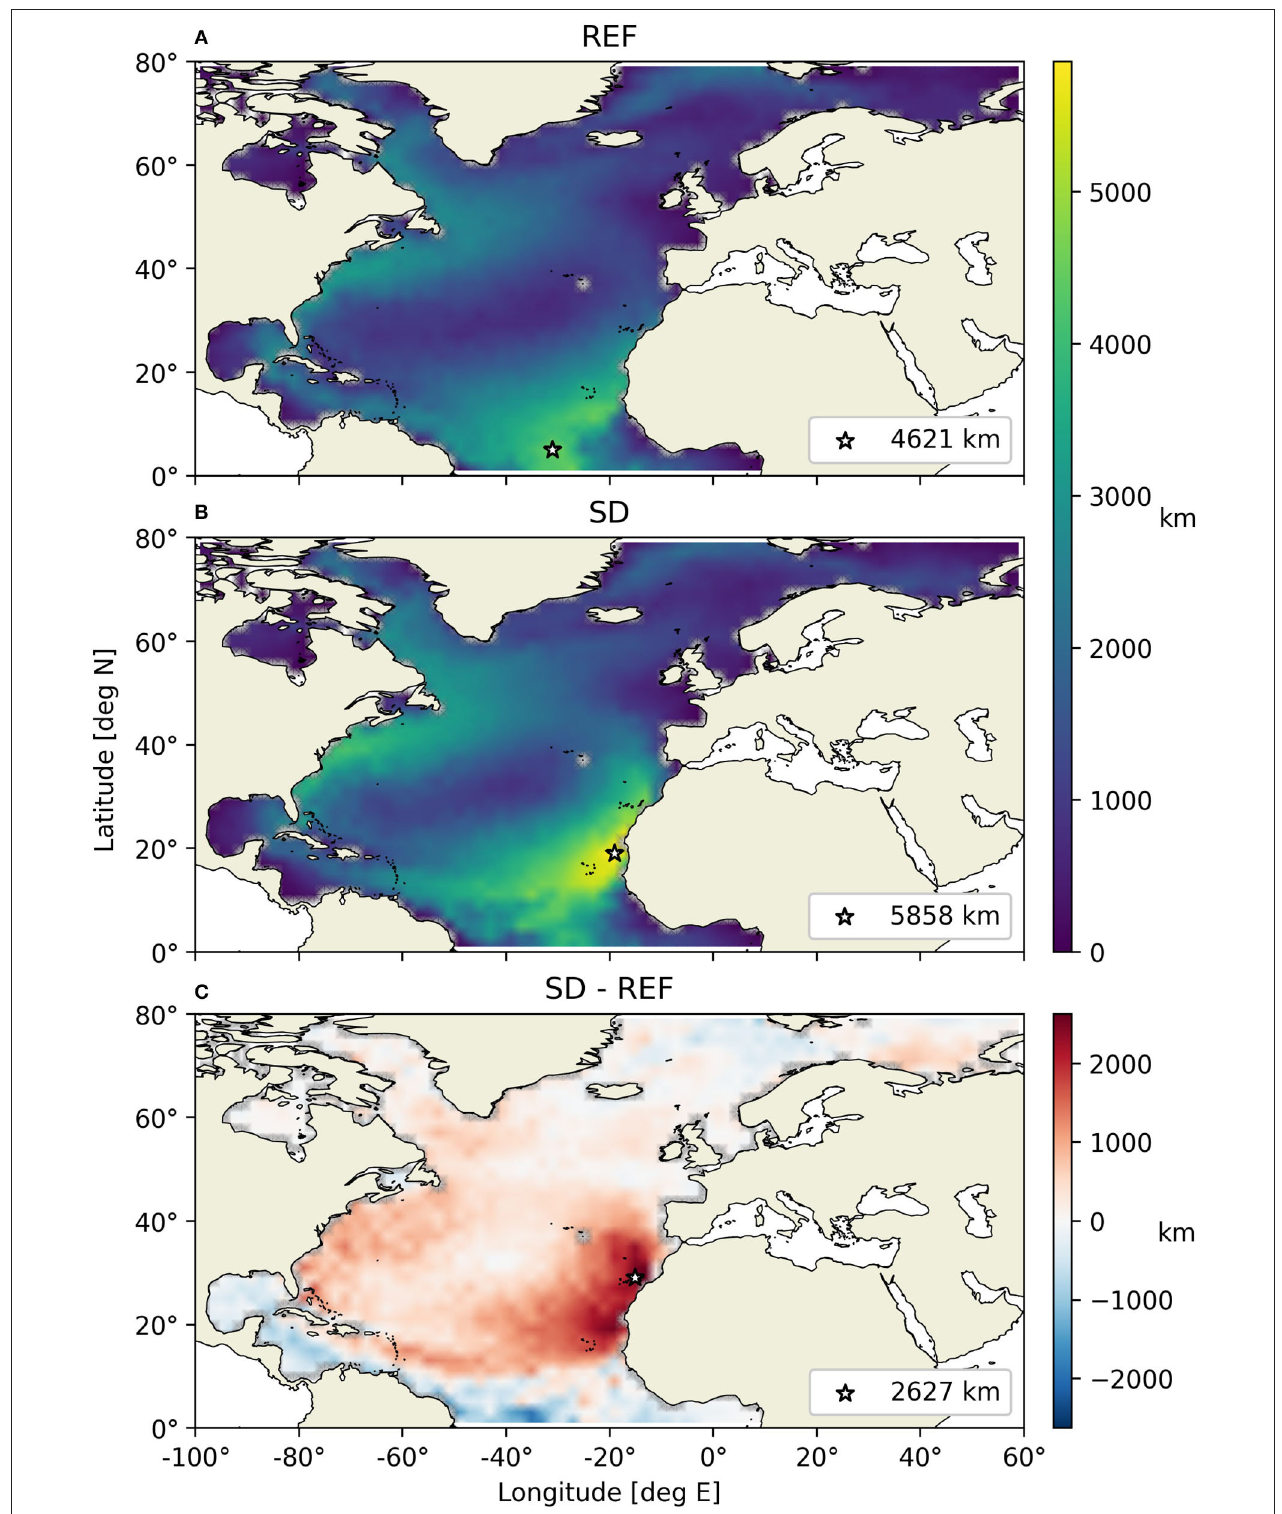
FIGURE 6 | Mean yearly dispersal distance, in km, for PTM-REF (A) and PTM-SD (B) calculated using P ij with a 1 t of 1 year, as in section 2.3. The bottom panel (C) shows the anomaly between the two experiments ( = MDD SD − MDD REF ). The star markers represent the maximum value in each figure.